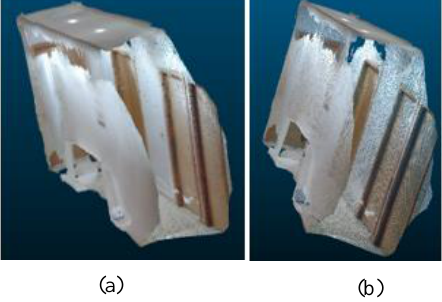
Figure 18. Subsampled and cleaned point cloud of the corridor: (a) without filter and (b) with filter.